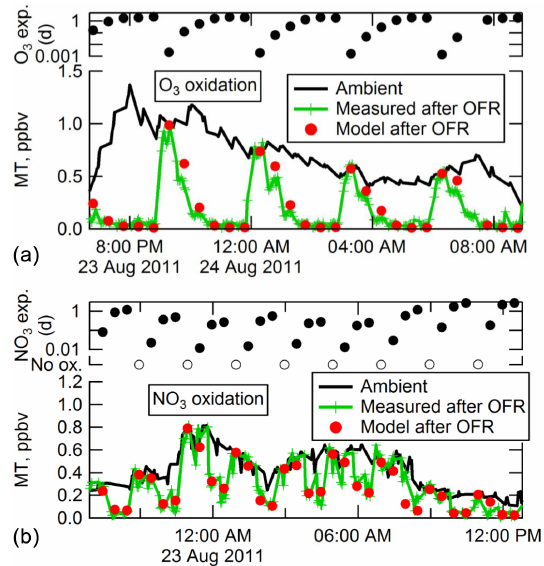
Figure 4. Ambient, measured remaining, and modeled remaining MT from O 3 oxidation on 23–24 August (a) and NO 3 oxidation on 22–23 August (b) in the OFR. Modeled O 3 and NO 3 exposures are also shown. The amount of oxidation was cycled from no added oxidant (no MT reacted) to maximum oxidation (most or all MT reacted) in repeated 2–3h